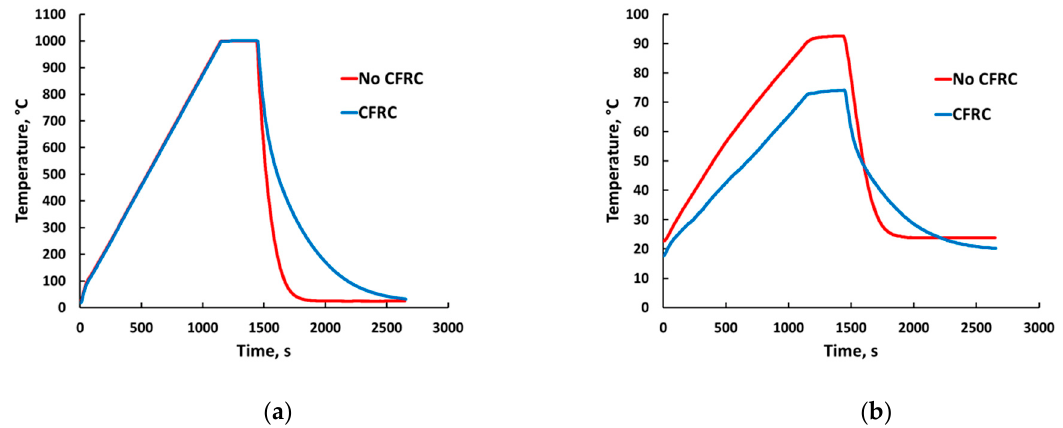
Figure 3. Temperature evolution recorded at ( a ) T_1 and ( b ) T_5 locations.